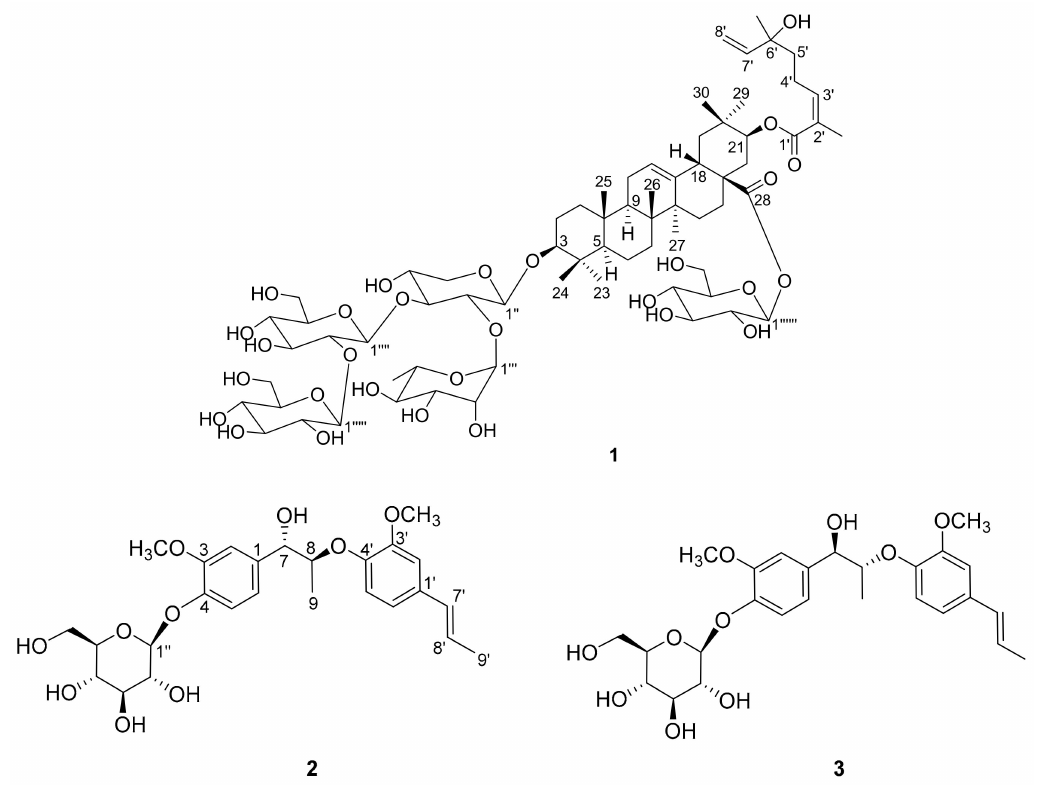
Figure 1. Chemical structures of compounds 1 – 3